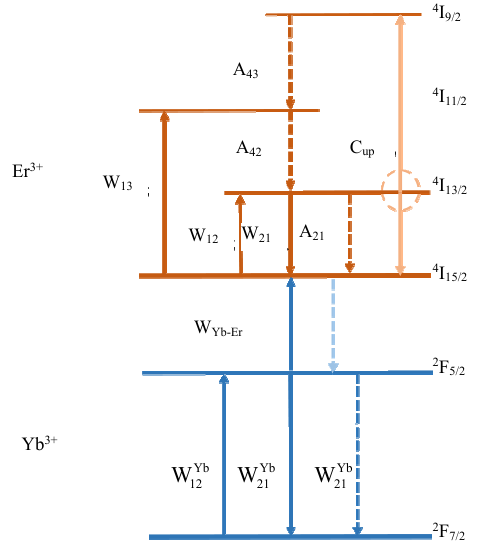
Fig. 2 Energy-level diagram of erbium-ytterbium co-doped